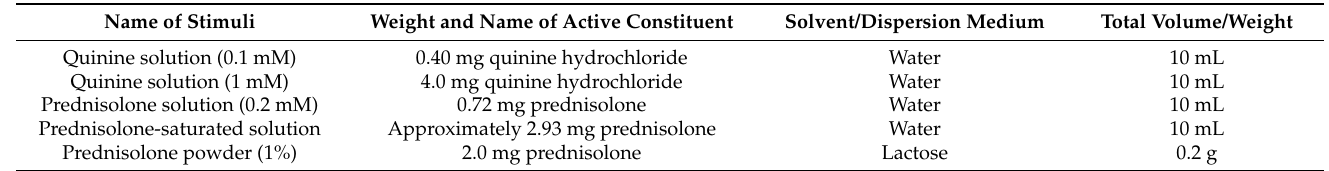
Table 1. Five stimuli were used when conducting the sensory